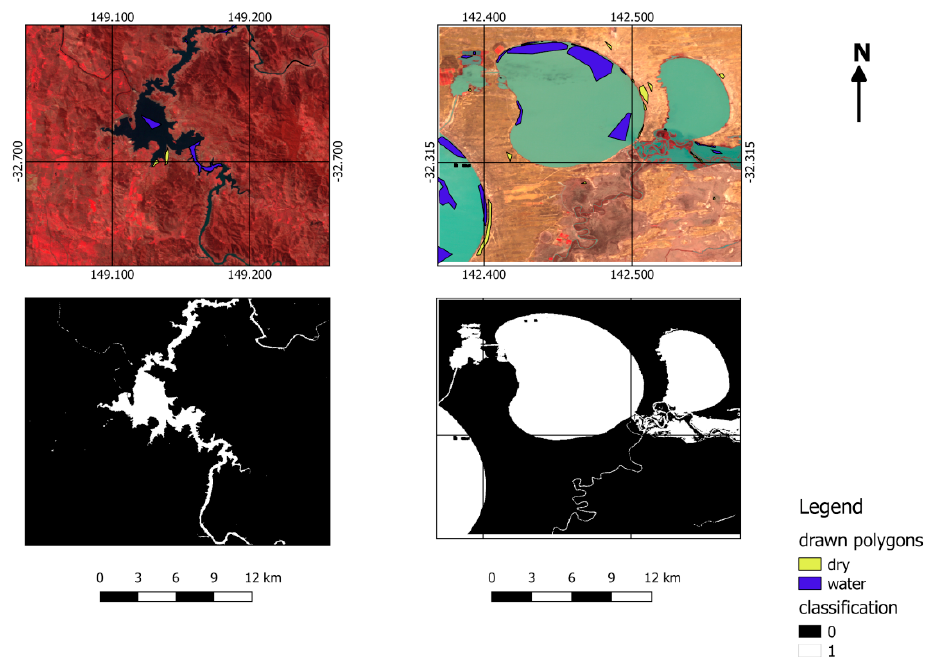
Figure 7. Two examples of areas where polygons classified as water (blue polygons) and dry (yellow polygons) were drawn to feed the classification and regression tree analysis (CART) classifier with their corresponding classifications. The background images where the polygons were drawn correspond to color infrared Landsat images.